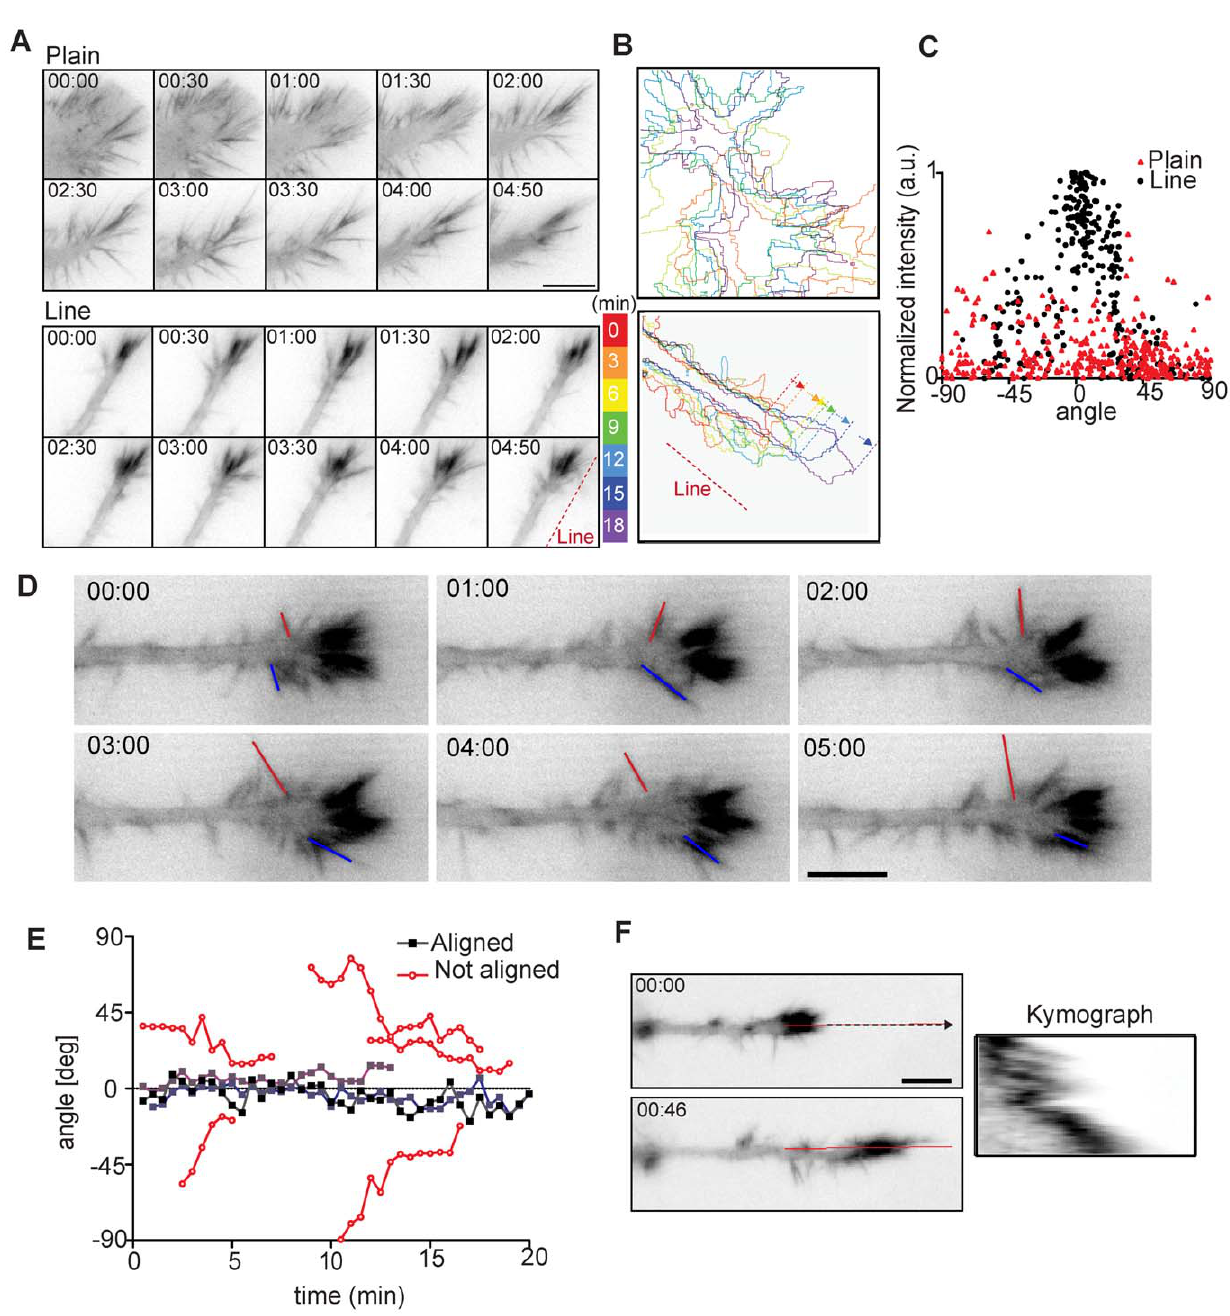
Figure 4. Growth cone filopodial dynamics. ( A ) Time-lapse series of growth cone filopodial dynamics on plain and line substrates. Cells were transfected with Lifeact-GFP and imaged using fluorescence microscopy. Time is in minutes:seconds. ( B ) Cellular outlines were captured and overlaid to show movement of neurite tip. ( C ) Analysis of correlation of filopodia alignment (angle compared to line direction) and normalized F-actin intensity on plain and line substrates. ( D ) Blowup of growth cone in (A), line substrate. Red and blue lines mark the locations of two filopodia. Notice back and forth movement of the filopodia and how blue labeled filopodia assembles a robust F-actin cytoskeleton when it aligns. ( E ) Angular trajectories of filopodia that are aligned or not aligned on the ridge patterns. ( F ) Kymograph analysis of filopodial dynamics of aligned filopodia. Bars: (A,D,F) 10 m m.